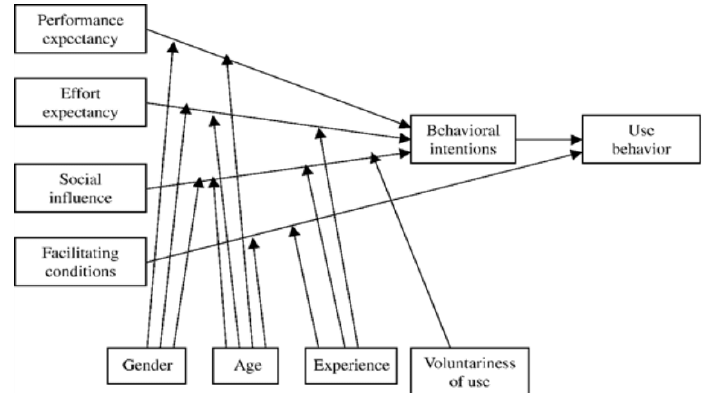
Fig. 4. Unified Theory of Acceptance and Use of Technology (UTAUT)